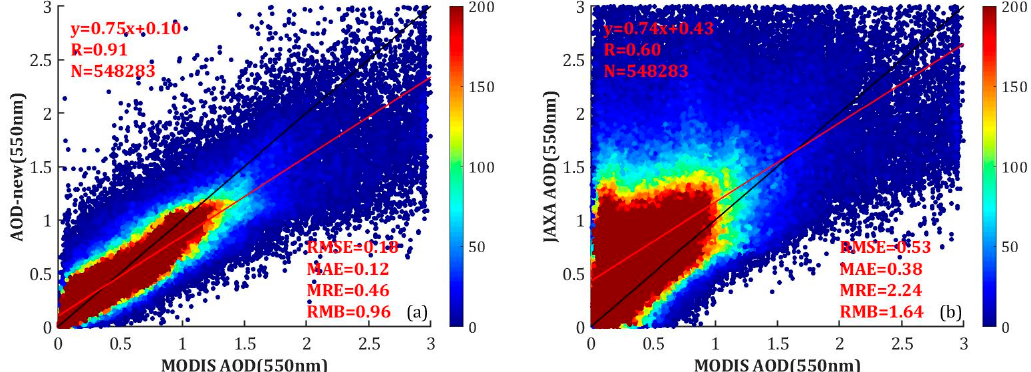
Figure 12. Intercomparison of AHI AOD and MODIS DB products. (( a ): AOD-new; ( b ): JAXA AOD). The colored bar represents the density distribution of the MODIS-AHI AOD pairs.